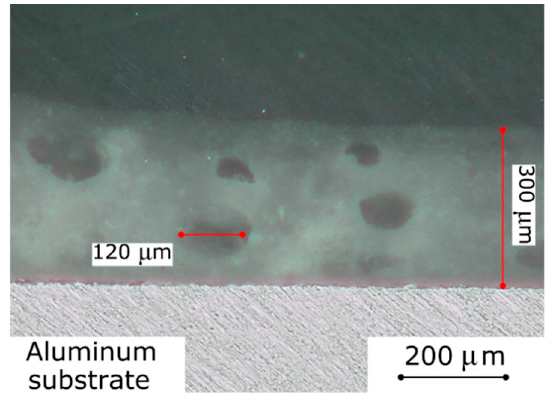
Figure 8. Macrograph of a zeolite based porous coating.